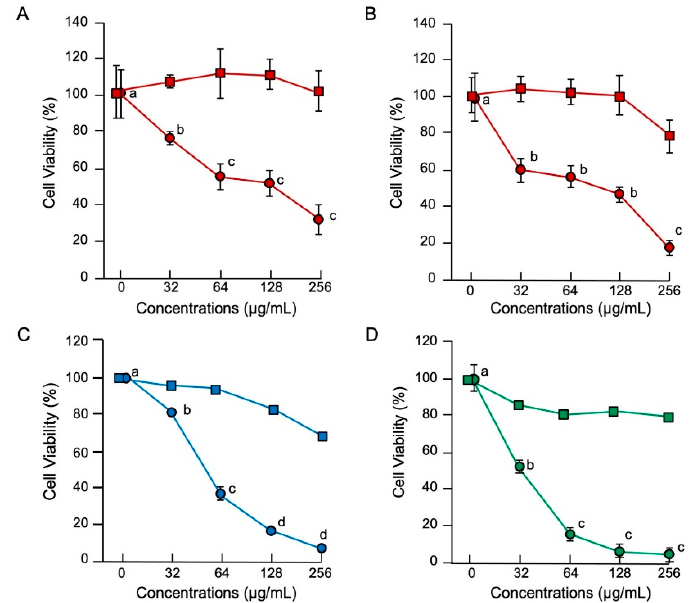
Figure 3. Cytotoxic effects of histone H3 in eukaryotic cells. Medium containing 1 × 10 4 HUVEC ( A ) or HAEC ( B ) or 5 × 10 3 COS7 ( C ) or HepG2 ( D ) cells in 500 μ L aliquots were incubated with histone H3 (circles) or myoglobin (squares) at 0, 32, 64, 128, or 256 μ g/mL for 24 h at 37 °C. Cell proliferation was determined using a standard MTT assay. Cell viability rates were calculated from MTT reduction values and are expressed relative to the control (0 μ g/mL). Each point and vertical bar represent the mean and standard error of the mean, respectively ( n = 4). In all panels, values with the same letters are not significantly different among histone H3 treatments ( p ≥ 0.05). Cell lines of normal, immortal, and tumor cell lines are colored in red, blue, and green, respectively.